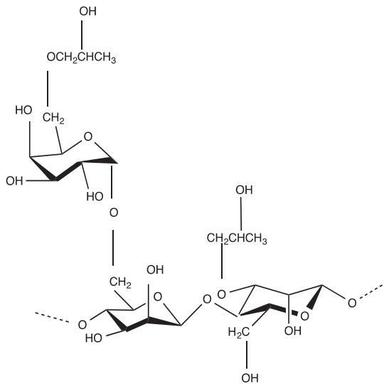
Structure of hydroxypropylguar. Reproduced from with permission.